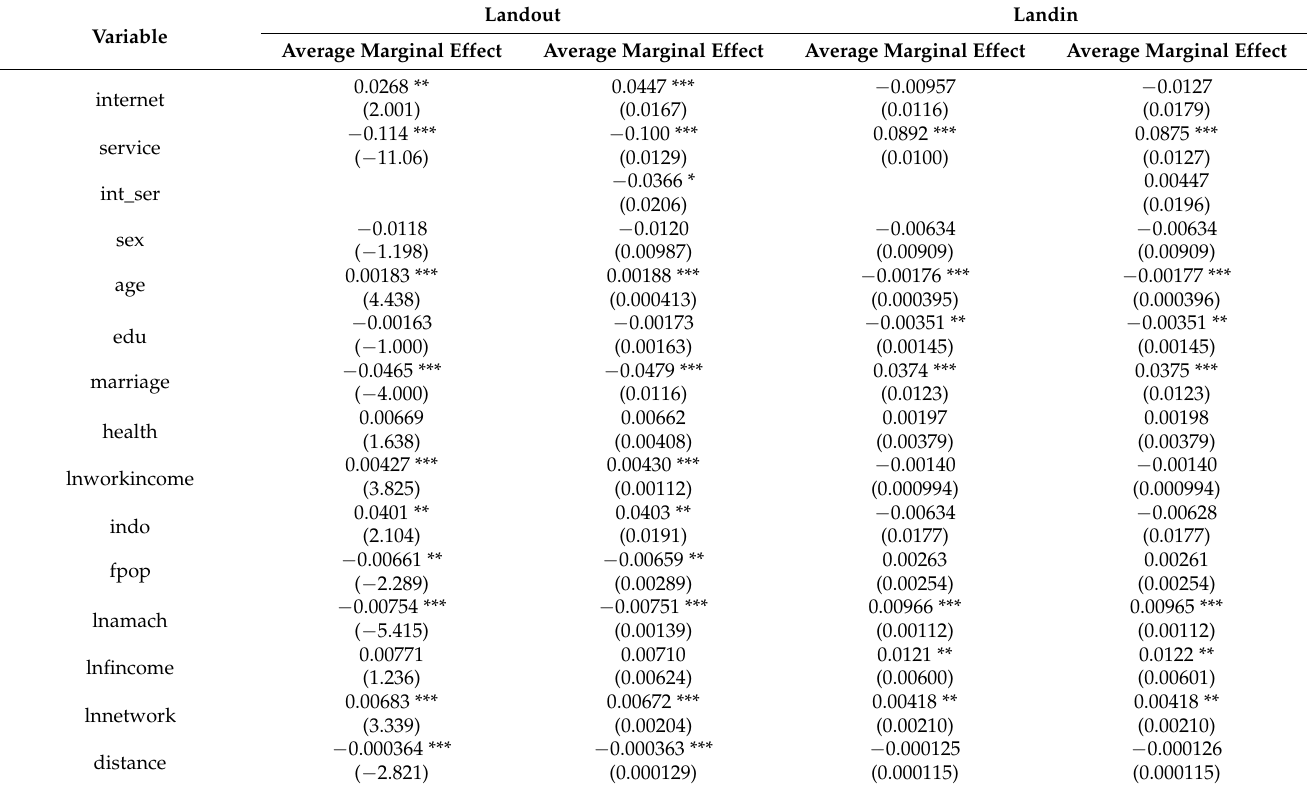
Table 2. Basic regression to land-scale